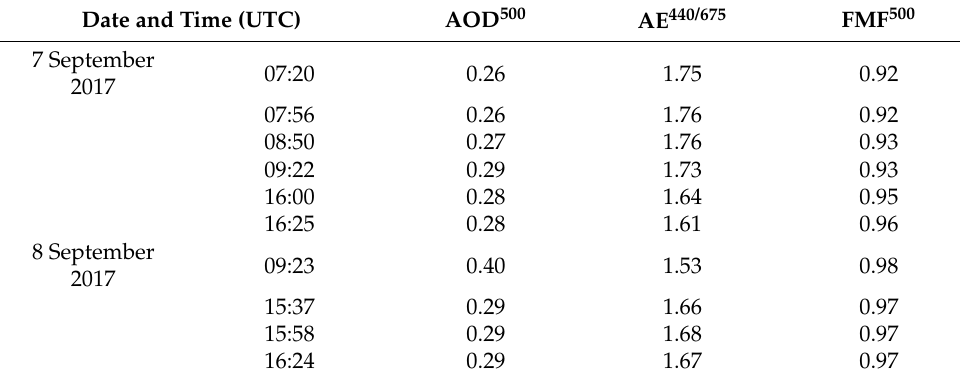
Table 2. Aerosol Optical Depth at 500 nm (AOD500), Angstrom Exponent at the pair of wavelengths 440 nm and 675 nm (AE440/675), and Fine Mode Fraction at 500 nm (FMF500) for the 10 selected cases of the aged smoke